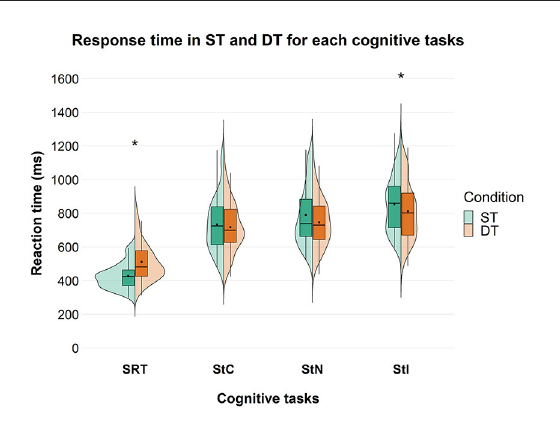
FIGURE3 Response time in ms between ST and DT, across the different cognitive tasks in the overall group. Significant differences between ST and DT are marked with an asterisk. SRT, Simple Reaction Time; StC, Congruent Stroop Test; StN, Neutral Stroop Test; StI, Incongruent Stroop Test.